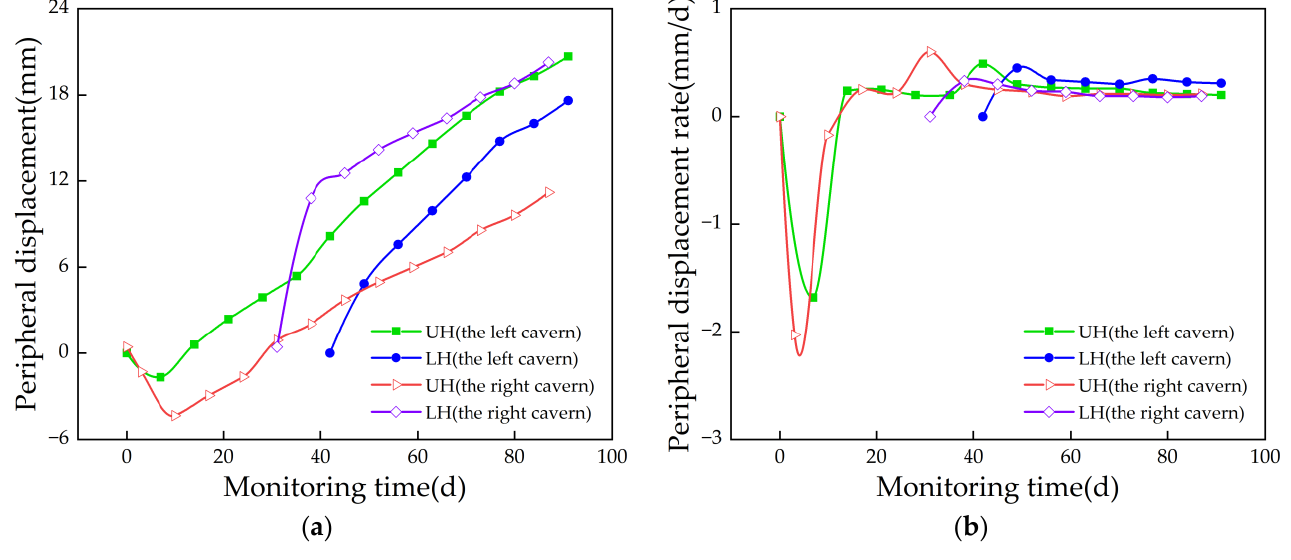
Figure 7. Peripheral displacement and displacement rate versus time. ( a ) Peripheral displacement; ( b ) peripheral displacement rate.